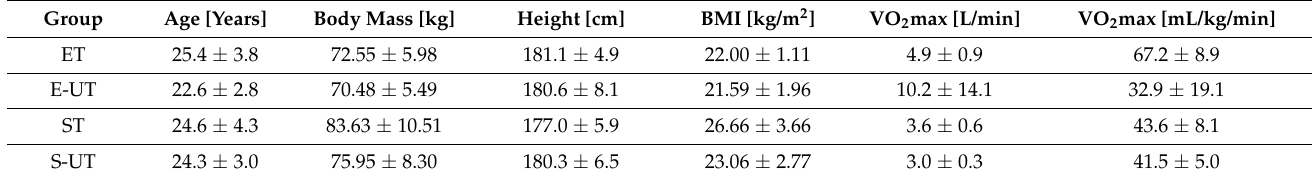
Table 1. Anthropometric data and maximal oxygen consumption (VO 2 max) of highly endurance-trained (ET), highly strength-trained (ST) and untrained control groups, who completed either an acute endurance (E-UT) or strength session (S-UT). Data are arithmetic mean ± standard deviation. n = 8 in each group.